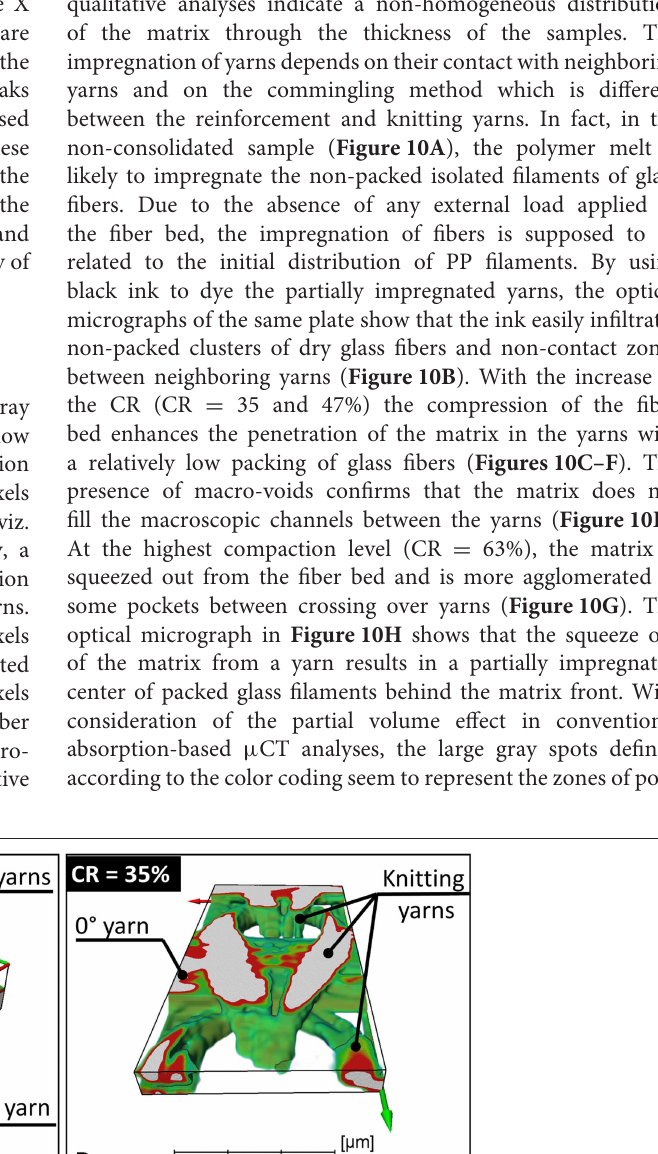
Frontiers in Materials |